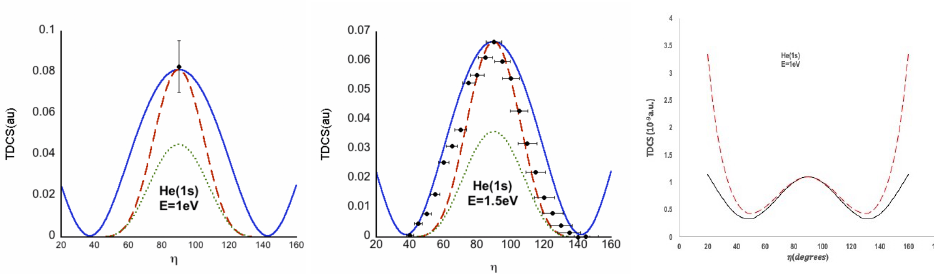
Figure 9. TDCS for the ionization of helium with Φ = 90 ◦ , θ 1 = θ 2 = η , E 1 = E 2 = E eV. Electron impact: The absolute measurement of [38] ( left panel ) is shown, and the relative measurements of [40] ( middle panel ) the DWBA (triplet exchange) without pci, solid blue line; DWBA with N e − e − factor normalized to 1 at Θ = 180 ◦ , dashed red line, DWBA with M e − e − dotted green line; Positron impact ( right panel ): DWBA without pci, solid black line, DWBA + N e + e − , dashed